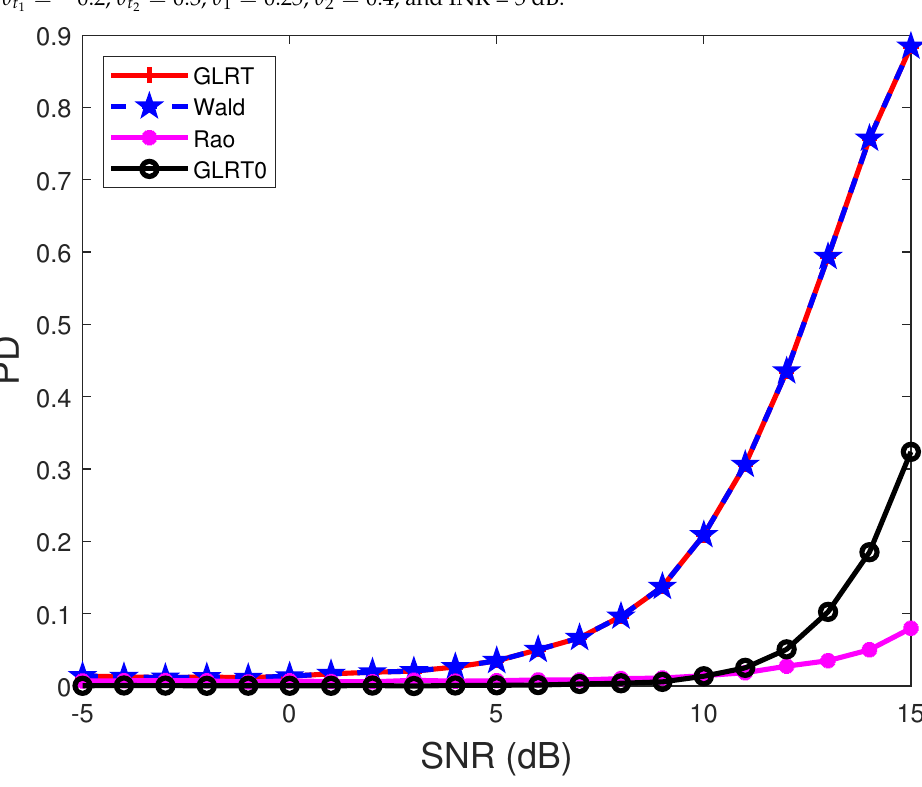
Figure 3. PDs of the detectors under different SNRs. R ( i 1 , i 2 ) = 0.95 | i 1 − i 2 | e ( i 1 − i 2 ) 0.05 , θ t = 0.2, θ 1 = 0.25, θ 2 = 0.3, θ 2 = 0.4, N = 8, p = 1, M = 2 N , and INR = 5